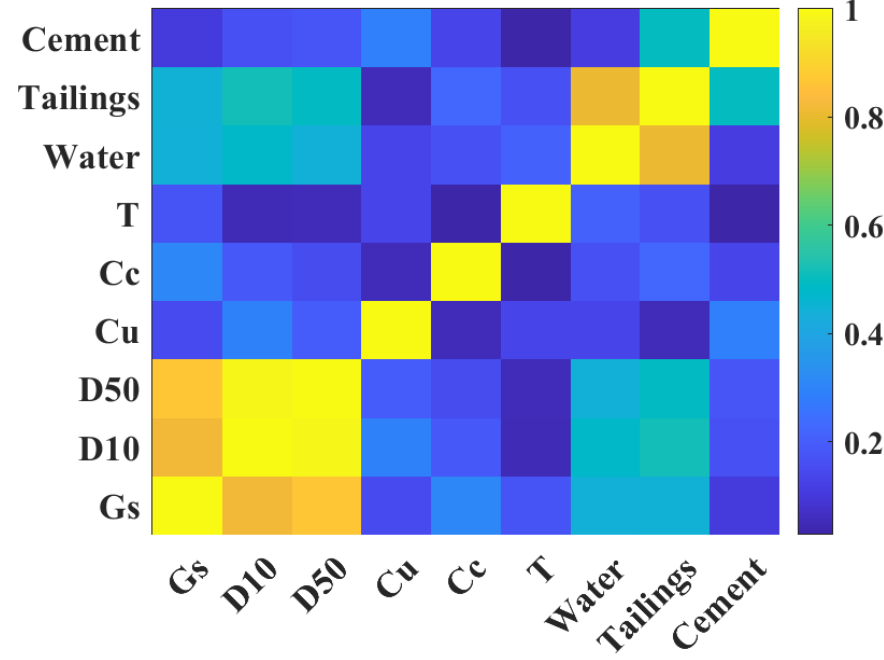
Figure 3. Correlation analysis between input variables.